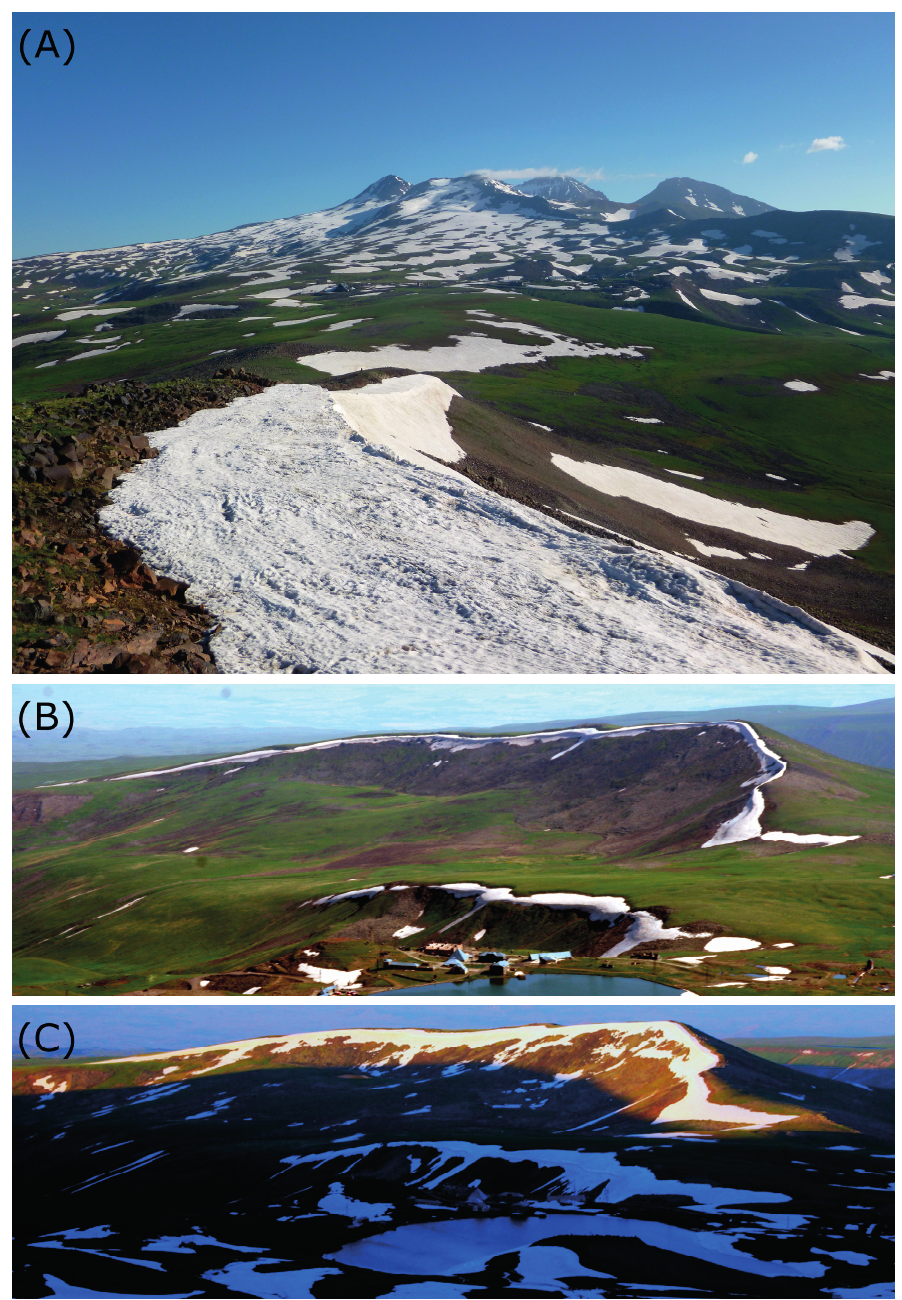
Figure 1. Snow fields on Mount Aragats: ( A ) June 2013; ( B ) June 2011; and ( C ) June